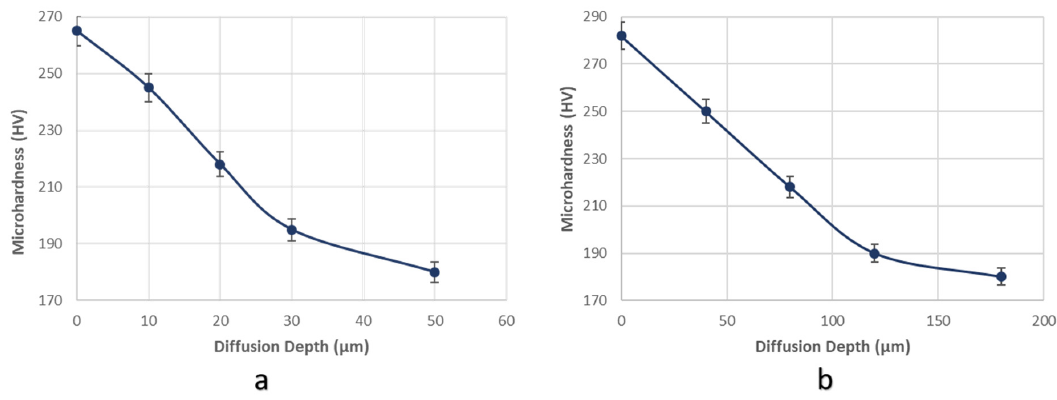
Figure 6. Determination of hydrogen cations’ diffusion depth into the polycrystalline matrix by conducting microhardness mesurements at the cross sections of the specimens, after in situ hydrogen cathodic charging polarization process during slow strain rate bending loading at ( a ) 10 mA/cm 2 and ( b ) 20 mA/cm 2 current density. By the use of second Fick’s law was calculated the diffusion coefficient of hydrogen cations into the matrix structure. D = x 2 /4 t